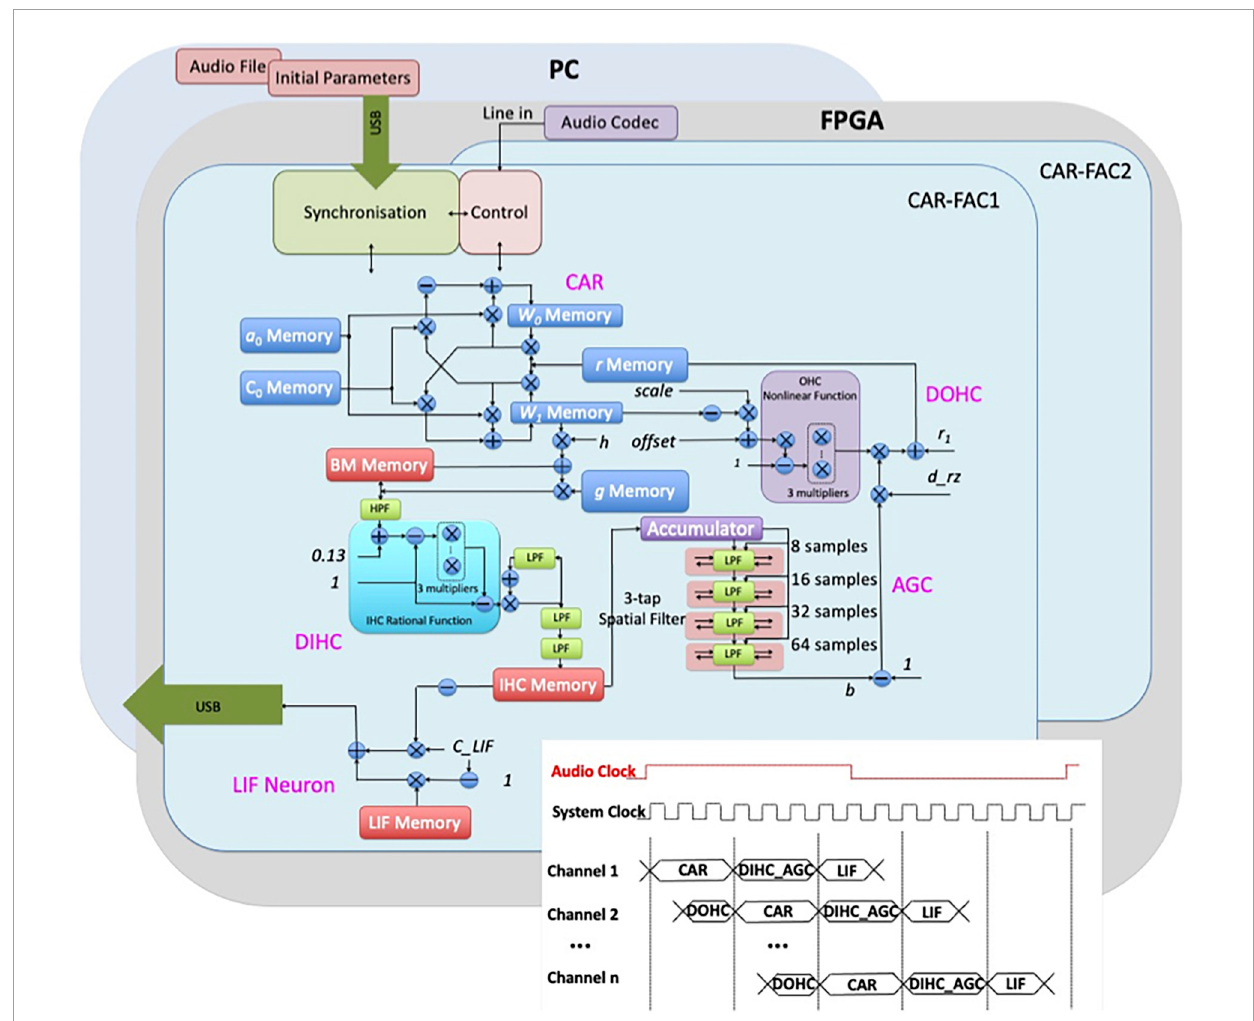
FIGURE2 Architecture of the binaural CAR-FAC FPGA system. The system consists of an audio codec and two “ears.” Each of the ears includes a CAR-FAC module, a controller module, and an interface module. The FPGA board is hosted by a PC through a USB interface. The inset shows the system timing diagram demonstrating the pipelined CAR-FAC. With time multiplexing and pipeline techniques, a binaural real-time n-channel CAR-FAC system is built using only one CAR-FAC module and one LIF module for each